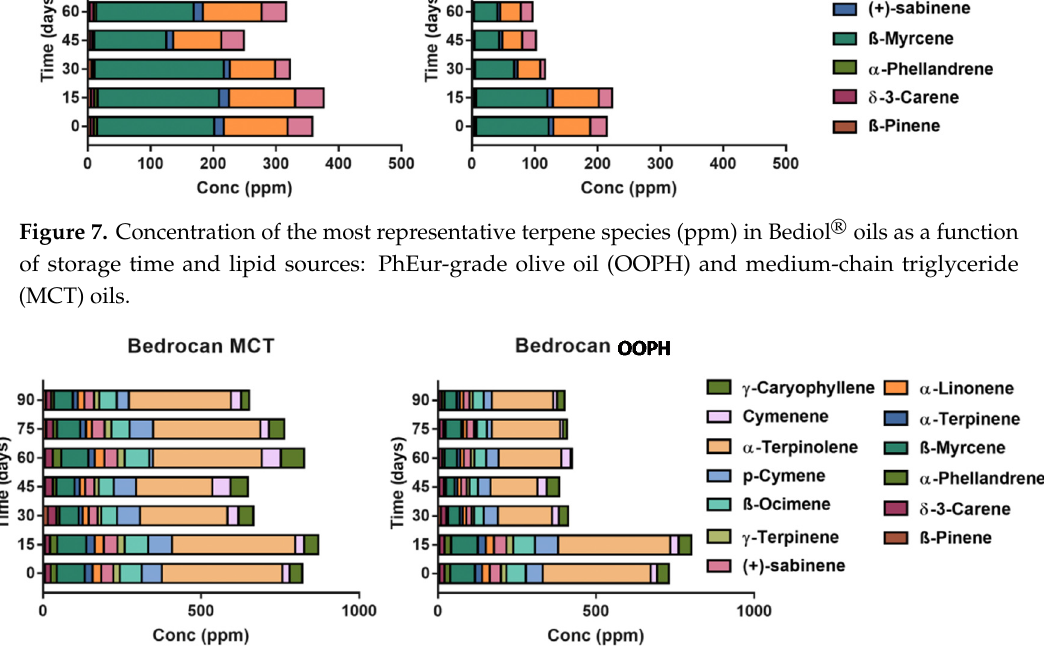
Figure 8. Concentration of the most representative terpene species (ppm) in Bedrocan ® oils as a function of the storage time and lipid: PhEur-grade olive oil (OOPH) and medium-chain triglyceride (MCT) oils.